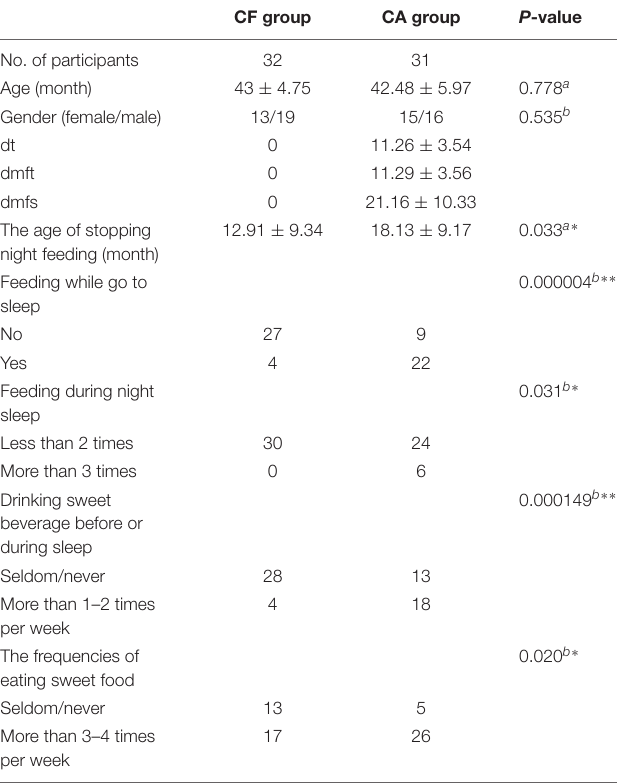
TABLE 1 | The demographic, dmft and oral behavior habits of the participants.